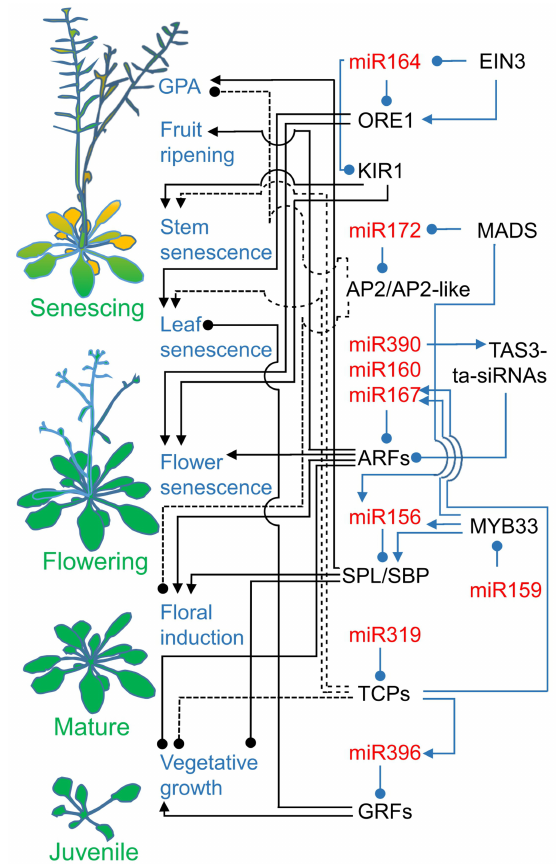
Figure 3. MicroRNAs’ contribution to the management of senescence in plants. MicroRNAs and their regulatory circuits are associated with various aspects of senescence. The individual panels represent plants at four developmental stages and illustrate the traits regulated by senescence-associated microRNAs. MicroRNA156 overexpression postpones flowering and promotes vegetative growth by targeting SQUAMOSA PROMOTER BINDING PROTEIN-LIKE/SQUAMOSA PROMOTER BINDING PROTEIN (SPL/SBP) transcription factors (TFs). MicroRNA172 stimulates flowering by downregulation of APETALA2 (AP2) mRNA. SPL TFs, together with microRNA172, act in the shoot apical meristem (SAM) to promote global proliferative arrest (GPA). MicroRNA160, microRNA167, and microRNA390 regulate auxin signal distribution by downregulation of AUXIN RESPONSE TFs (ARF) expression. MicroRNA396 controls leaf size and longevity by spatial and temporal restriction of growth-regulating factor (GRF) TFs expression. MicroRNA164-targeted ORESARA1 (ORE1) and KIRA1 (KIR1) stimulate flower senescence. ORE1 induces age-related cell death and de-greening in leaves. KIR1 controls cell death in stems. MicroRNA319 negatively regulates leaf senescence by targeting TEOSINTE BRANCHED/CYCLOIDEA/PCF (TCP) TFs. TCPs impact vegetative growth by inhibiting cell divisions. MicroRNAs are listed in red, proteins and siRNAs are depicted in black, regulated aspects of senescence are shown in blue, and plant developmental stages are identified in green. The arrows with triangular points reflect activation, and the arrows with circular tips reflect inhibition. The blue arrows represent regulatory circuits, and the black arrows connect circuits to regulated aspects of